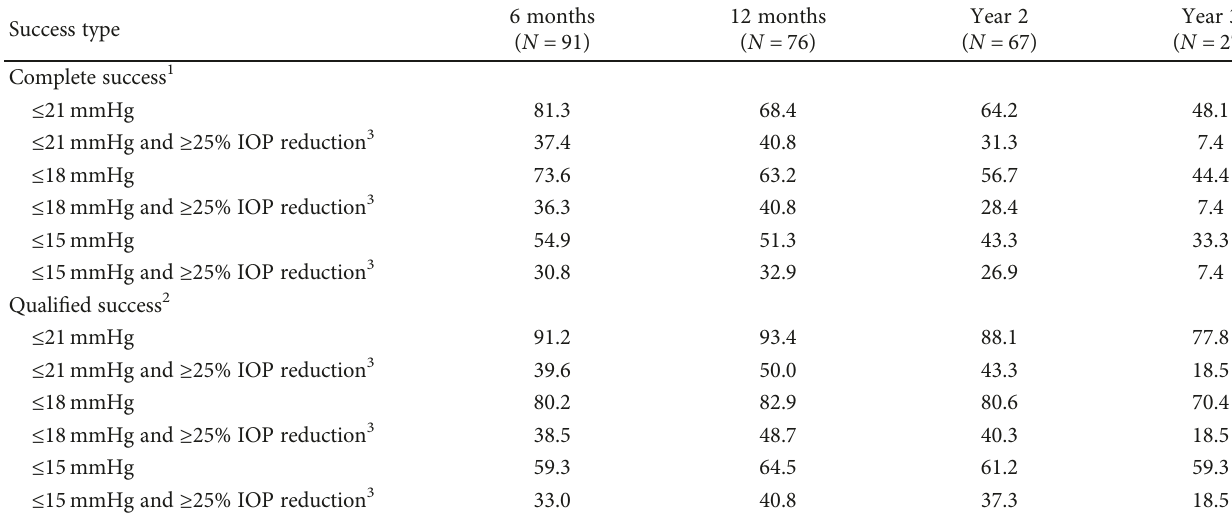
Table 7: Success rates (eyes with phacocanaloplasty).